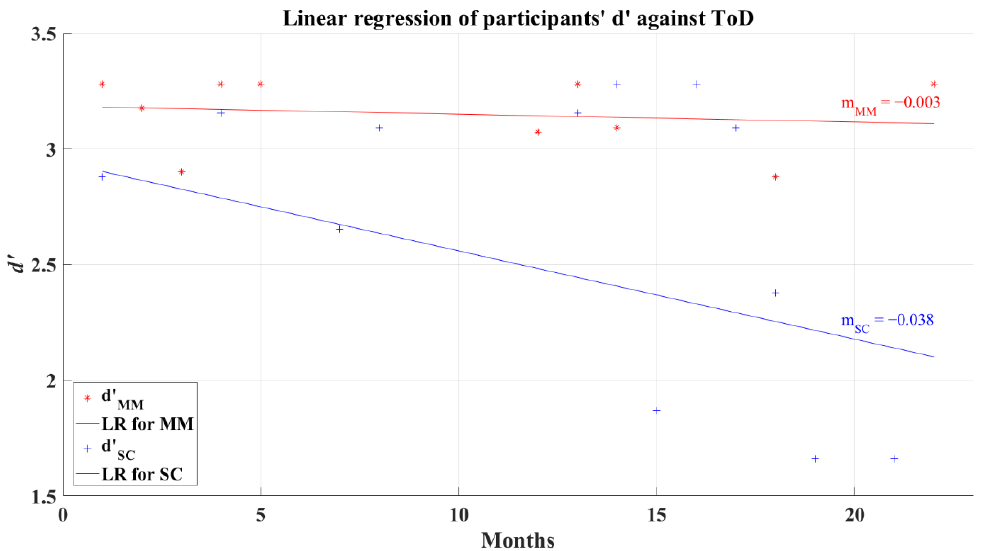
11 of 26 Figure 6. Linear regression of participants’ average d’ versus age for 2AFC-P1. Black line—linear regression for Control group (LR for CT); red line—linear regression for Mild-Moderate post- COVID group (LR for MM); blue line—linear regression for Severe-Critical post-COVID group (LR for SC); 𝑑′ (cid:3004)(cid:3021) , Control group’s efficiency index; 𝑑′ (cid:3014)(cid:3014) , Mild-Moderate group’s efficiency index; 𝑑′ (cid:3020)(cid:3004) , Severe-Critical group’s efficiency index; 𝑚 (cid:3004)(cid:3021) , Control group’s slope; 𝑚 (cid:3014)(cid:3014) , Mild-Moderate group’s slope; 𝑚 (cid:3020)(cid:3004) , Severe-Critical group’s slope. To evaluate if ToD affects d’, a correlation analysis was performed. Coefficients for both groups showed a non-significant correlation, and computed values were R = − 0.226